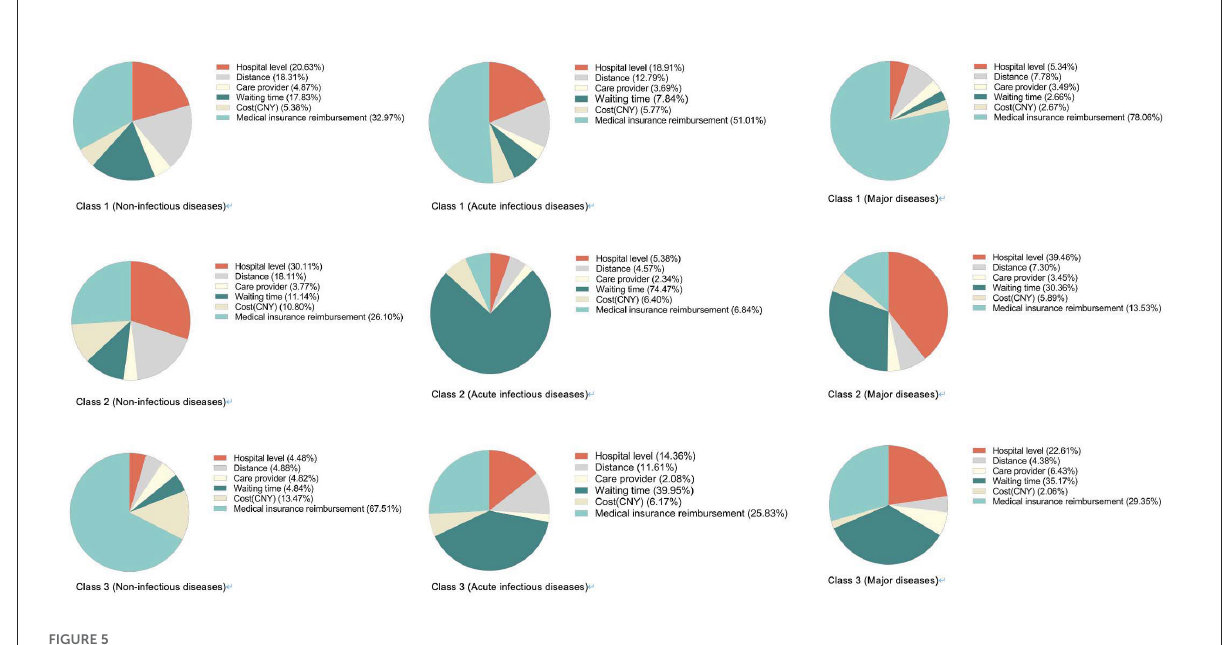
FIGURE5 Attribute importance of LC